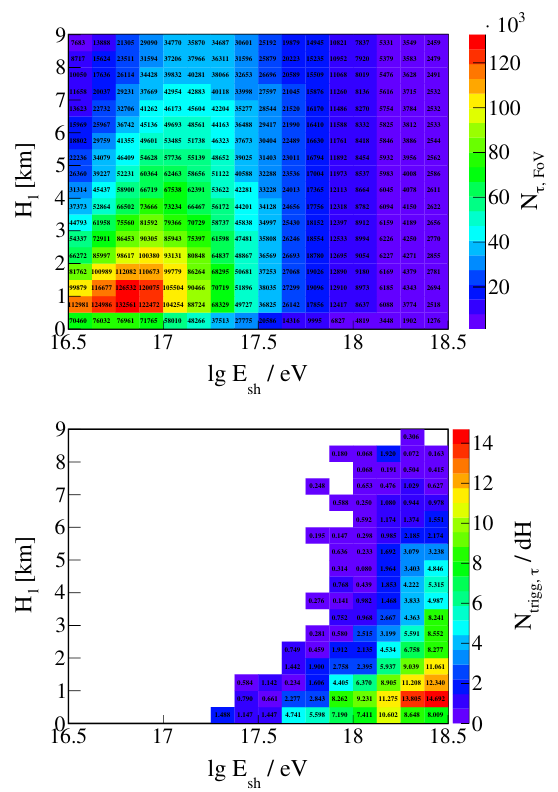
Figure 7. Distribution of MC-generated τ -decay induced EASs within the FoV of the FD (top panel) and corresponding number of FD-triggered events per height bin (bottom panel). The height H 1 corresponds to the distance D 1 in Fig. 6 and coincides with H fi .